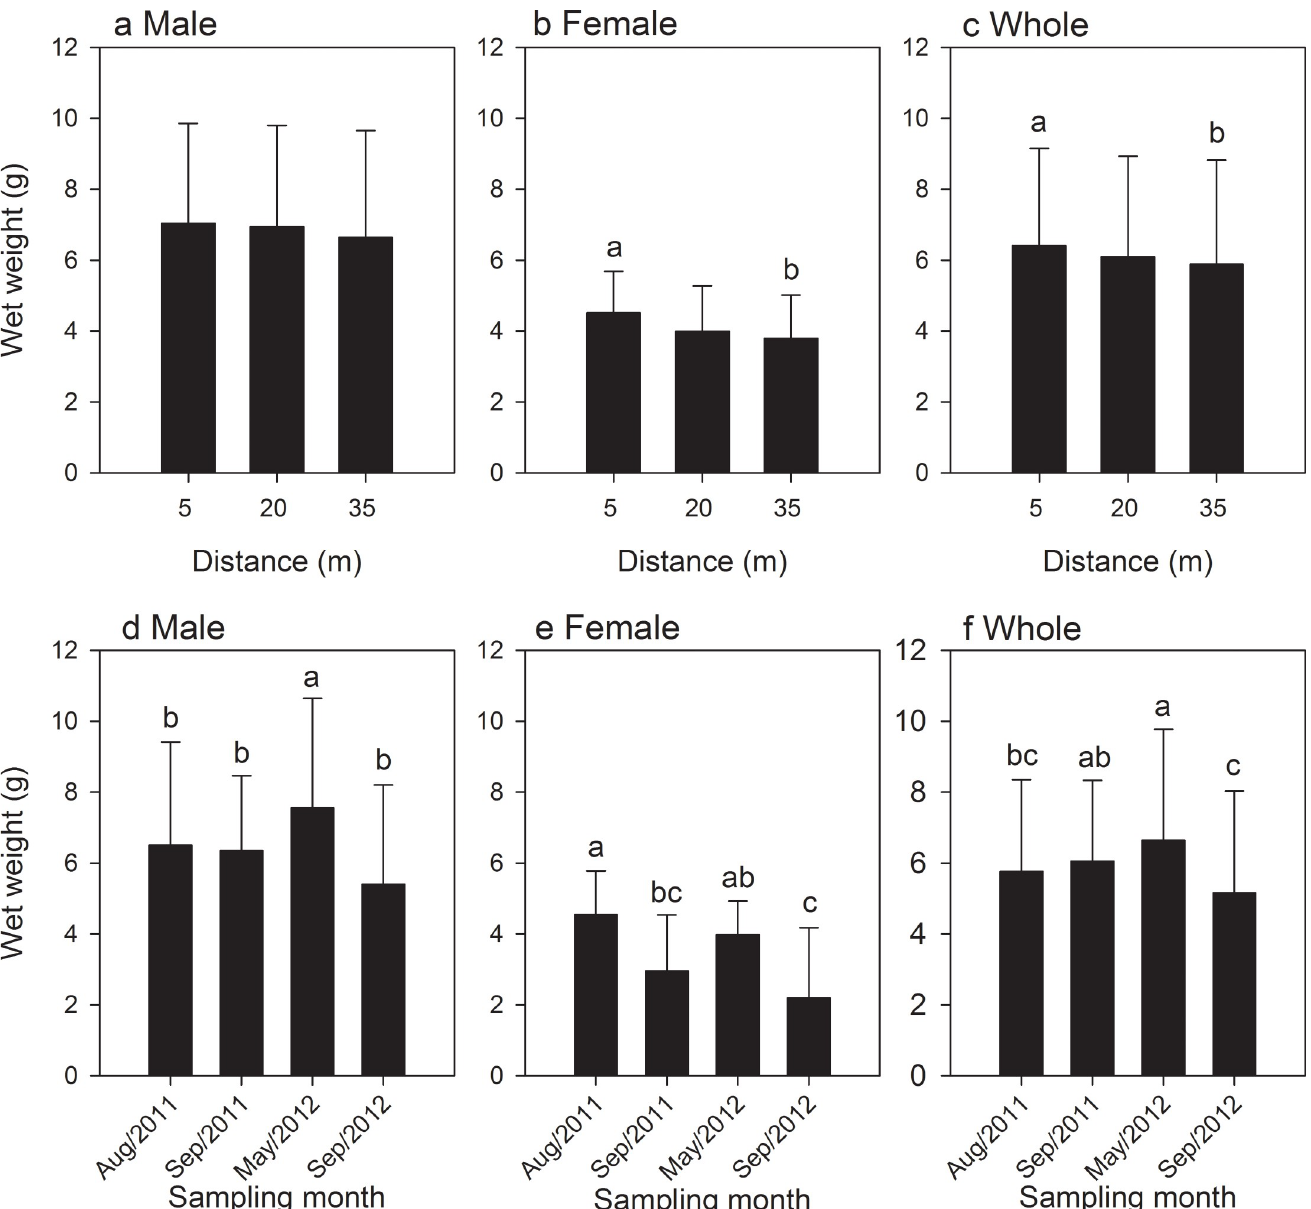
Fig 6. Statistical results of the wet weight of male (a), female (b) and whole crabs (c) of Xenograpsus testudinatus with a different sampling distance; as well as male (d), female (e) and whole crabs (f) of X . testudinatus with a different sampling month; the various superscripts indicate the significant differences ( p < 0.05, one-way ANOVA) among the sampling